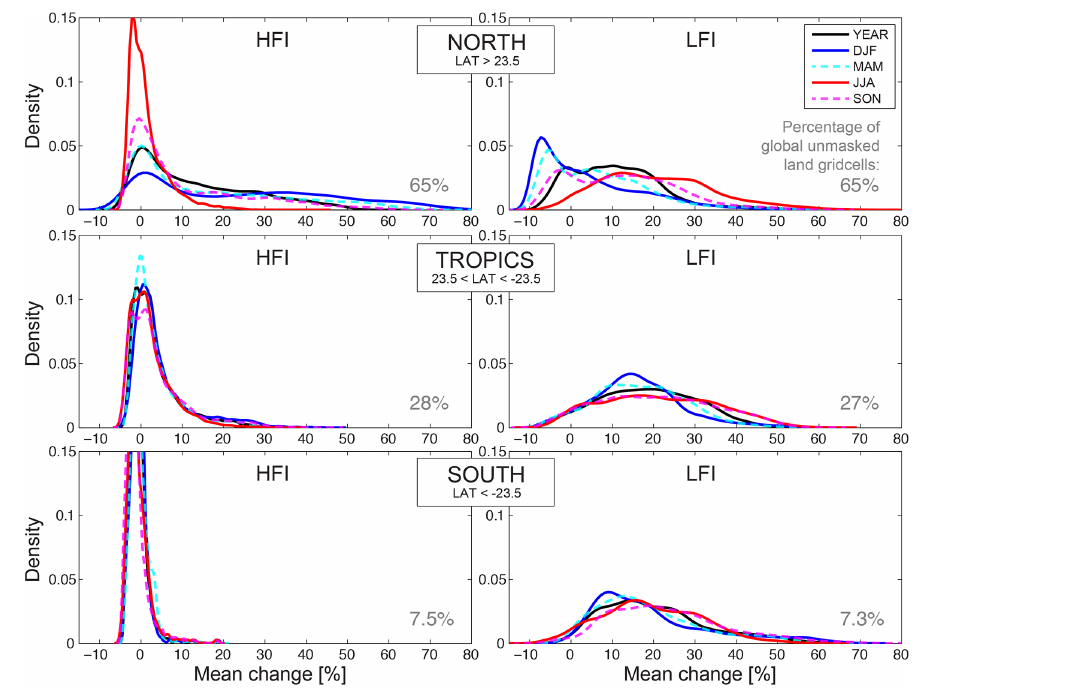
Figure 2. PDFs of mean changes in high (HFI) and low (LFI) flows, annually and per season (DJF and JJA) for North, Tropics, and South latitude